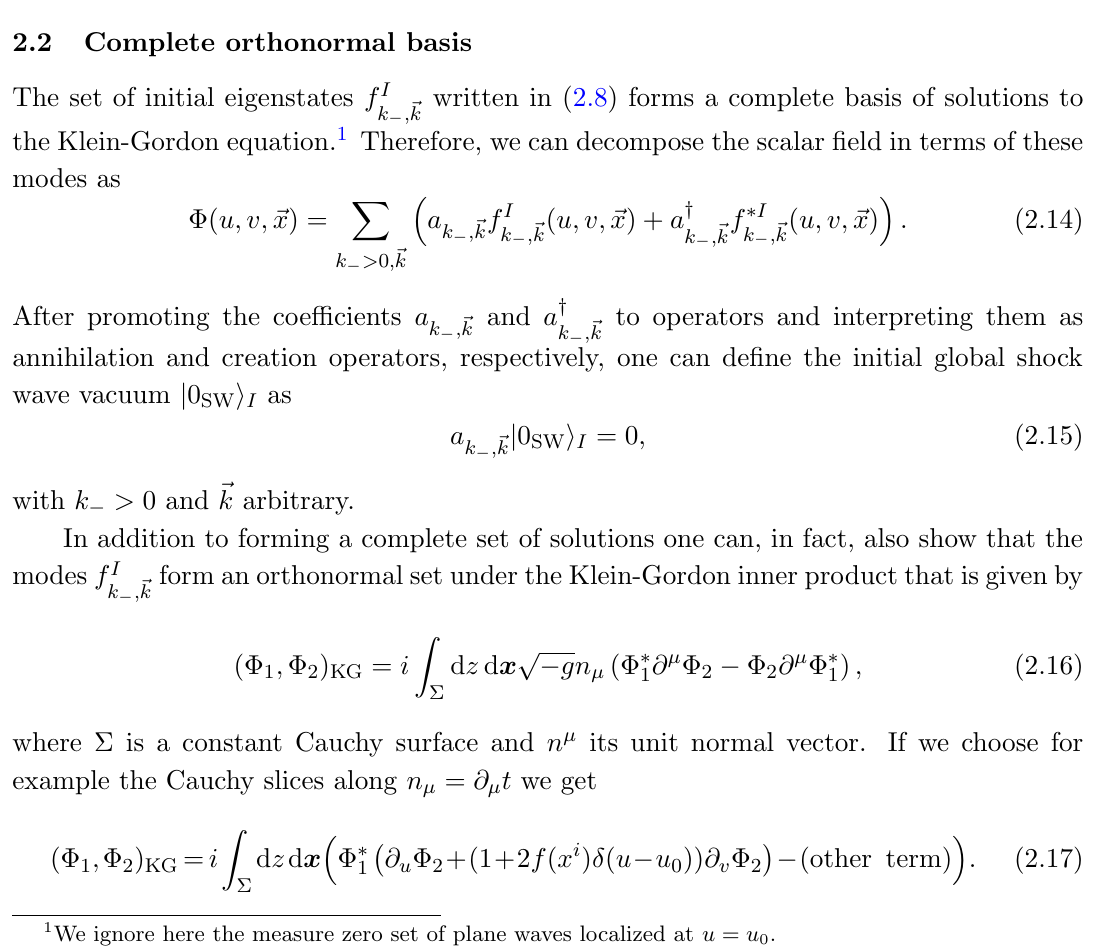
1 Figure 1 . Schematic depiction of initial and (cid:12)nal global plane wave eigenstates. The blank (shaded) part depicts the region where each solution is a plane wave eigenstate (a superposition of plane